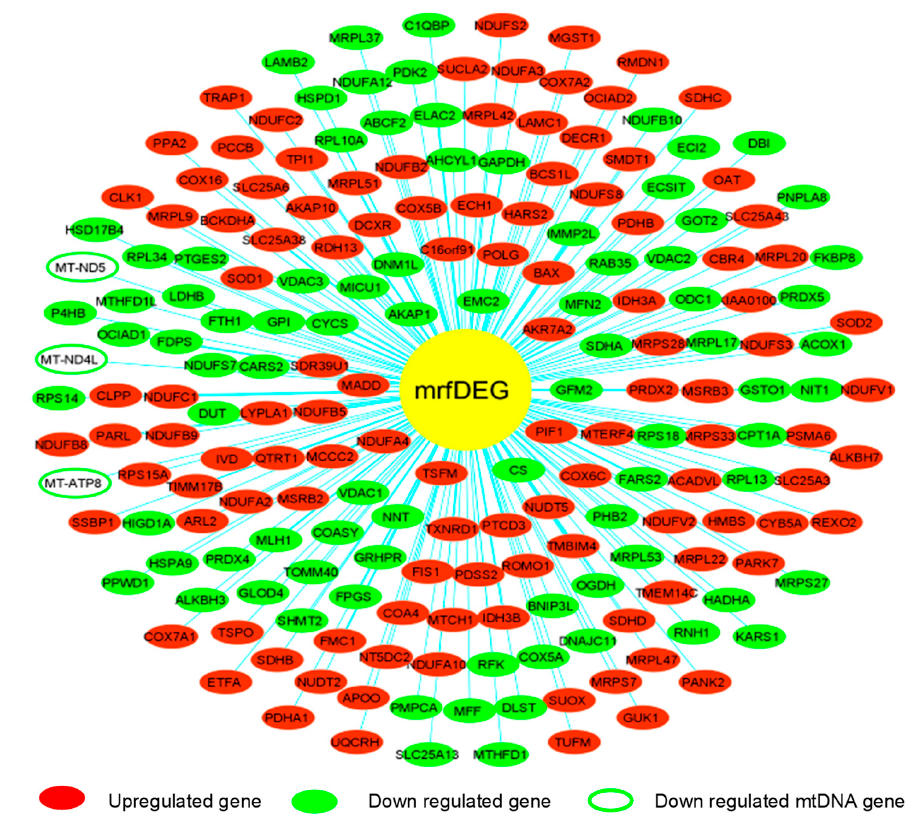
Figure 3. Pattern of expression of individual mitochondrial-related functional differentially expressed genes (mrfDEGs).